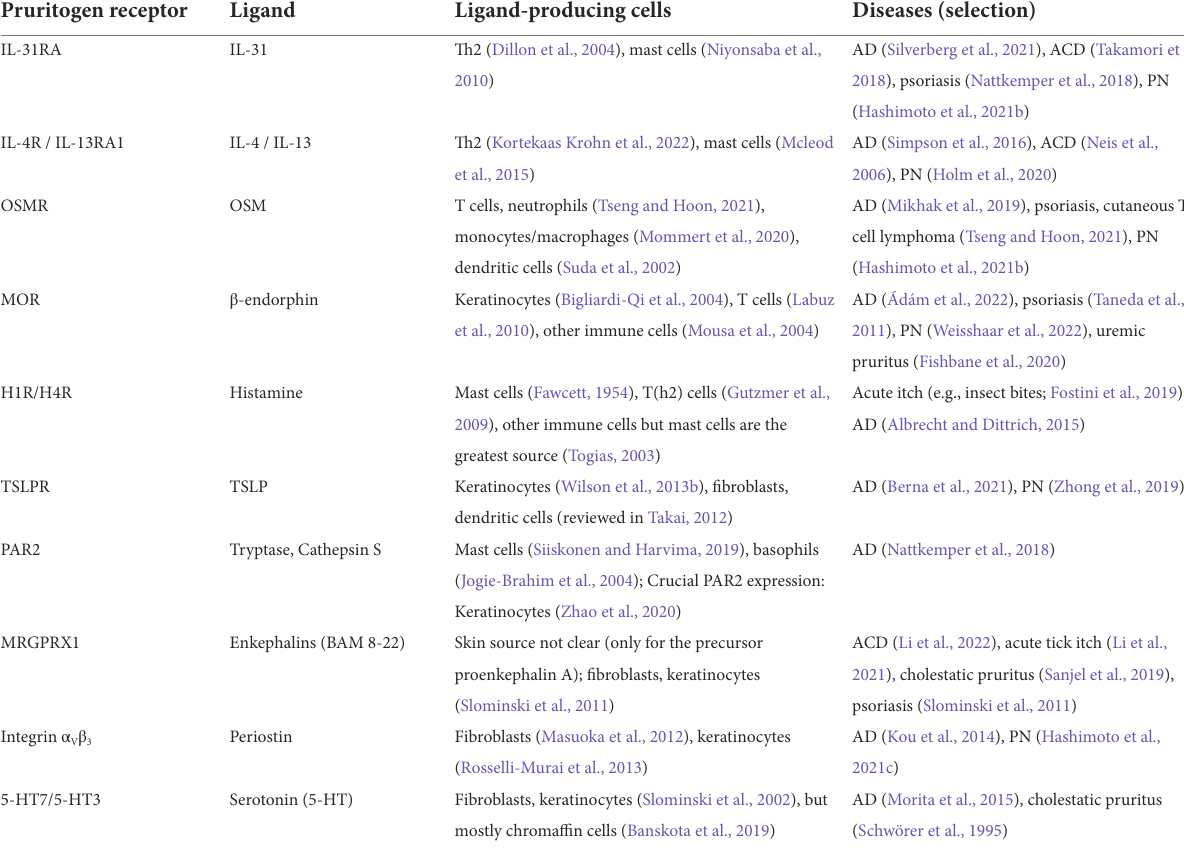
TABLE 1 Key sensory neuron pruritogen receptors and their endogenous ligand